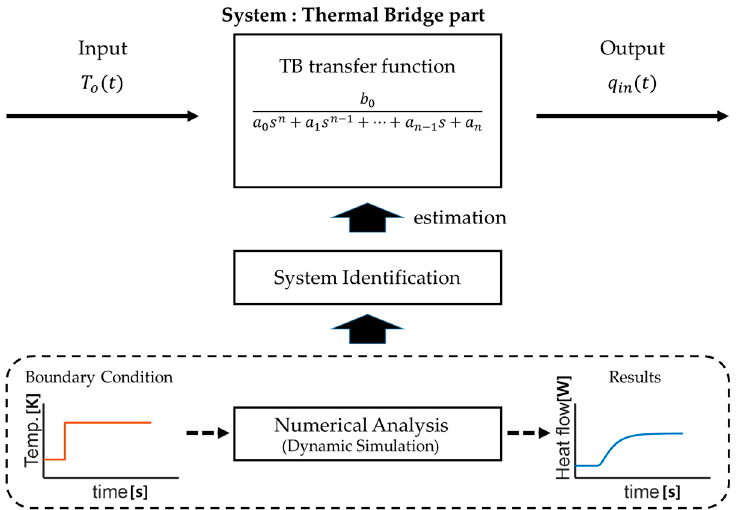
Figure 2. The strategy of the system identification for the TB part. System identification is used to estimate the parameters of the TB transfer function. Input/output data required for system identification are obtained through numerical analysis (dynamic simulation).